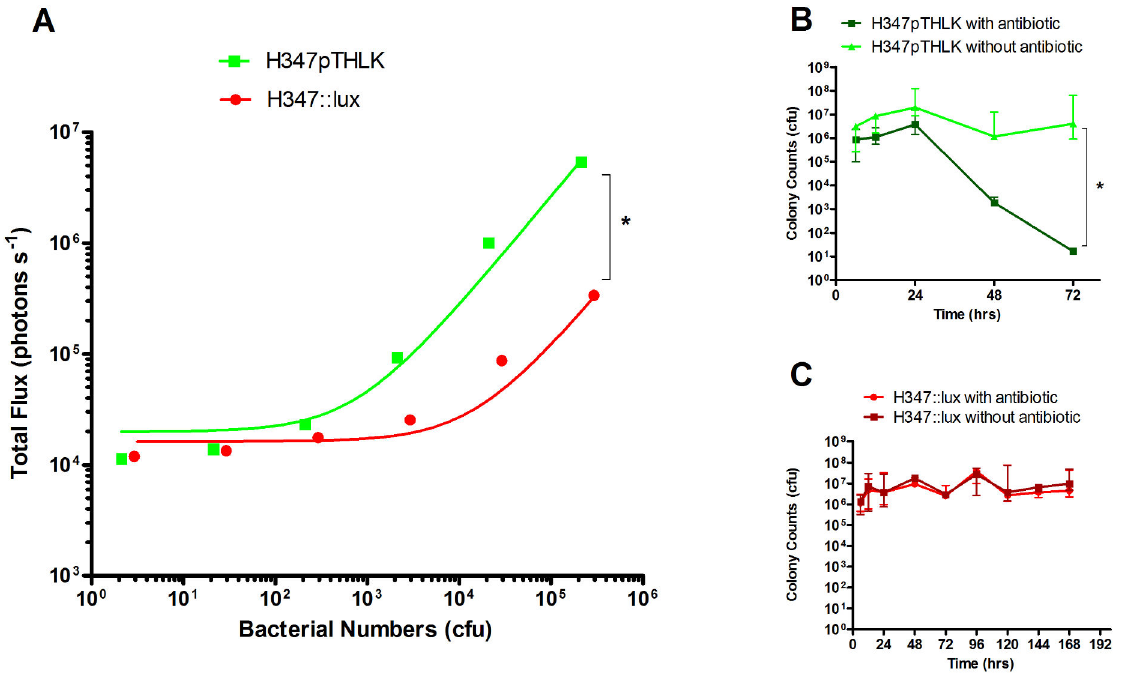
Figure 2. Characterization of bioluminescent strains in vitro . Serial dilutions of bioluminescent strains transformed with either plasmid (H347pTHLK) or integrated construct (H347::lux) were imaged in a 96 well plate (n= 3 separate cultures, Linear regression, r 2 >0.95, * p <0.05) using an IVIS 100 system (Perkin Elmer) to relate luminescence to bacterial abundance. Bacteria were quantified after plating onto agar